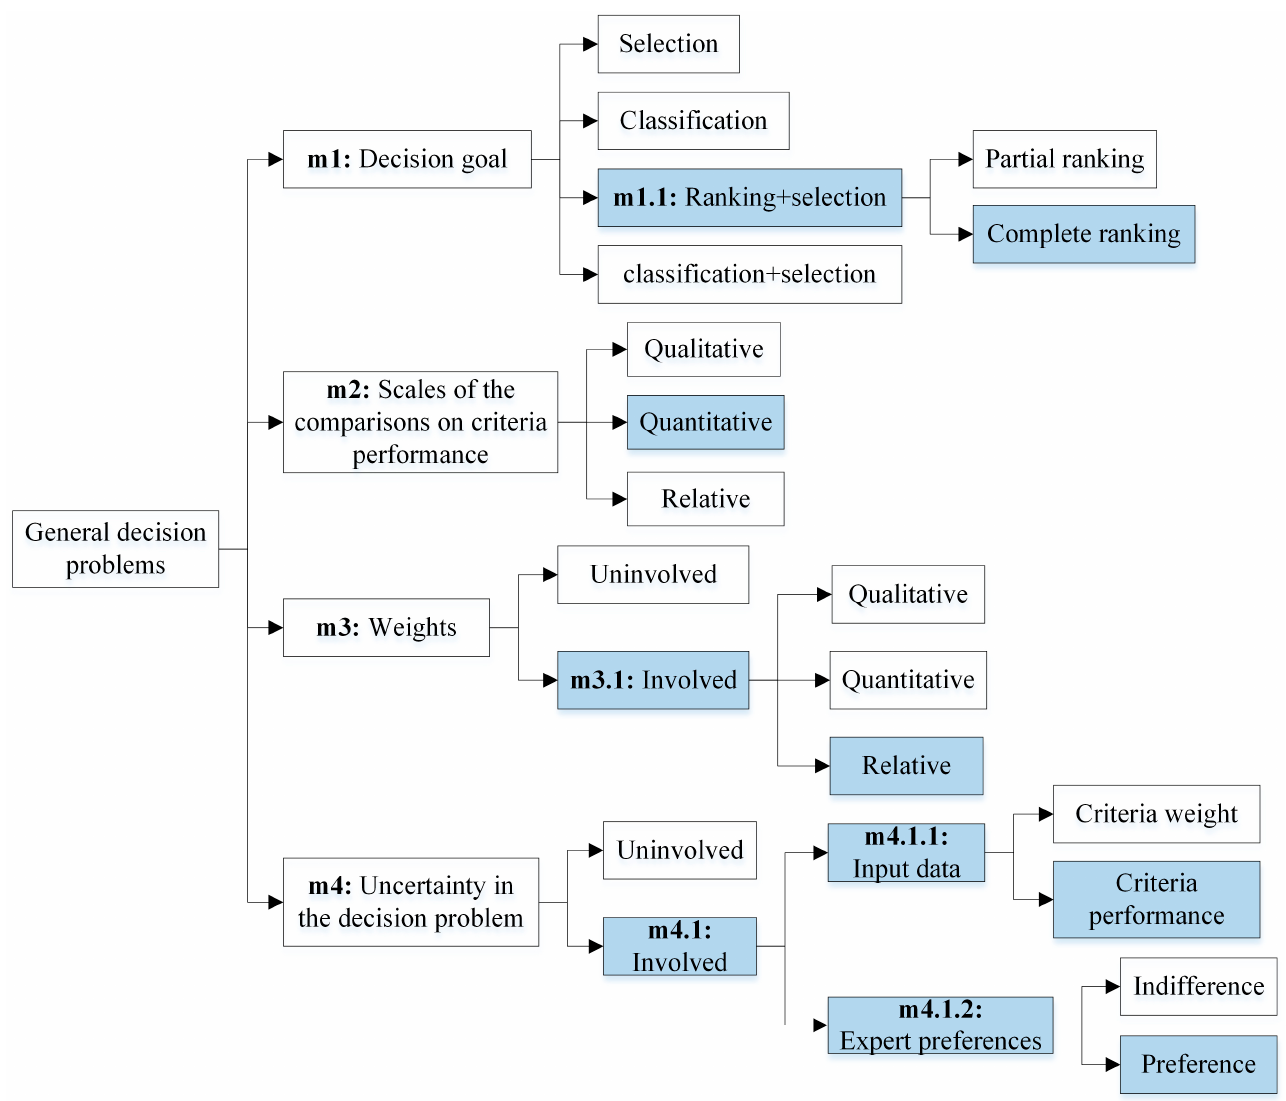
Figure 4. Characteristics of general decision problems. Table 1. Problem characteristics and method properties.